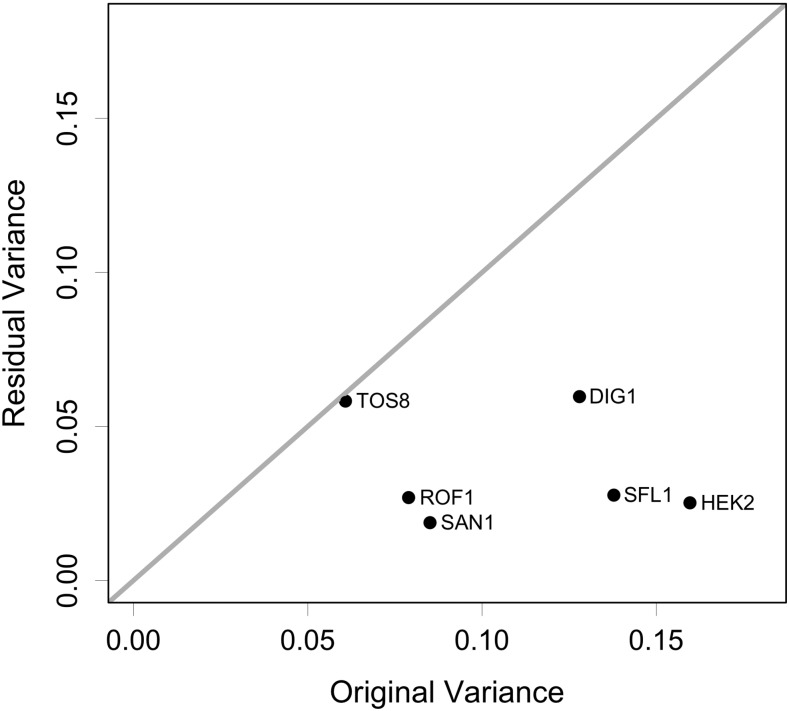
Initial variance in each overexpression strain (variance of log2 fold-change relative to F45) and residual variance unexplained by the common factor (using the communality values from factor analysis).